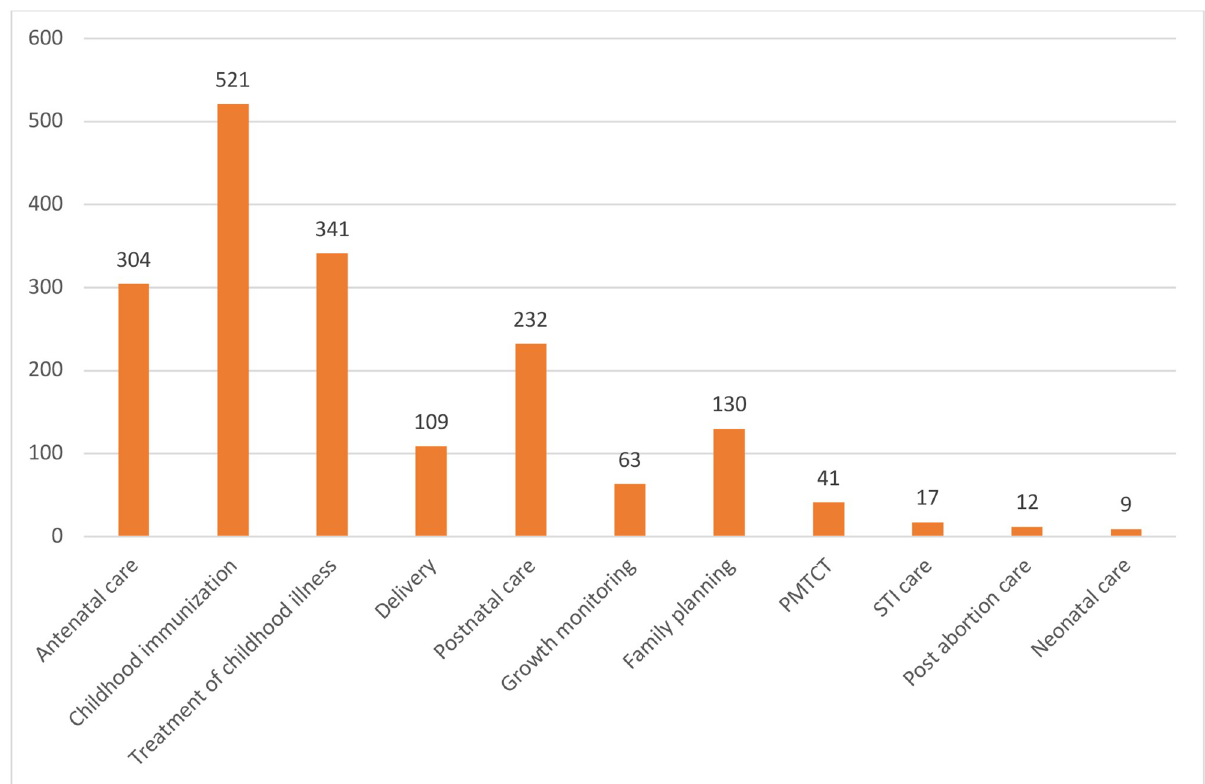
Fig 1. RMNCH services received during the COVID-19 outbreak in